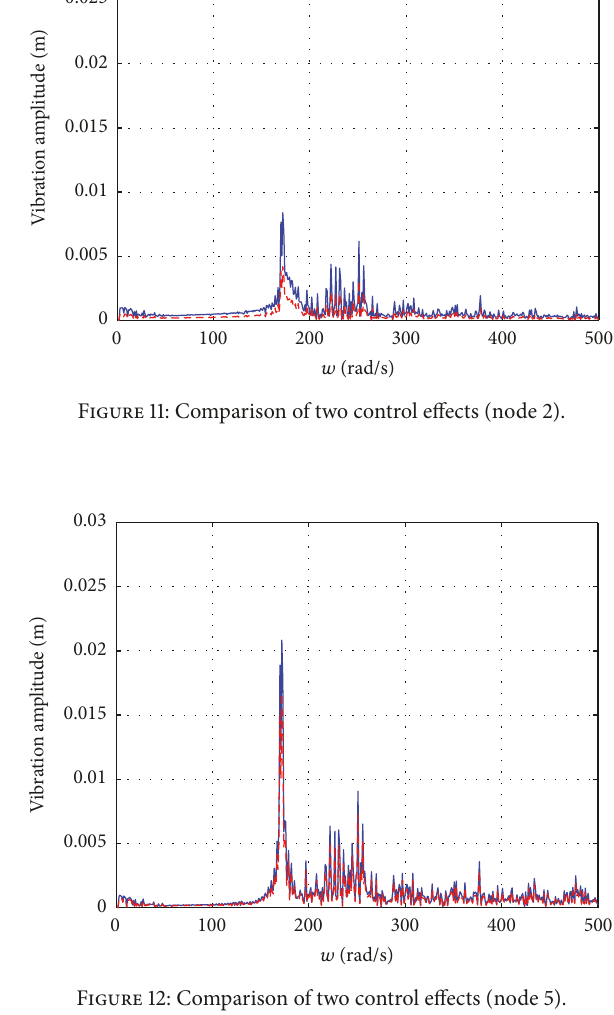
Figure 12: Comparison of two control effects (node 5).